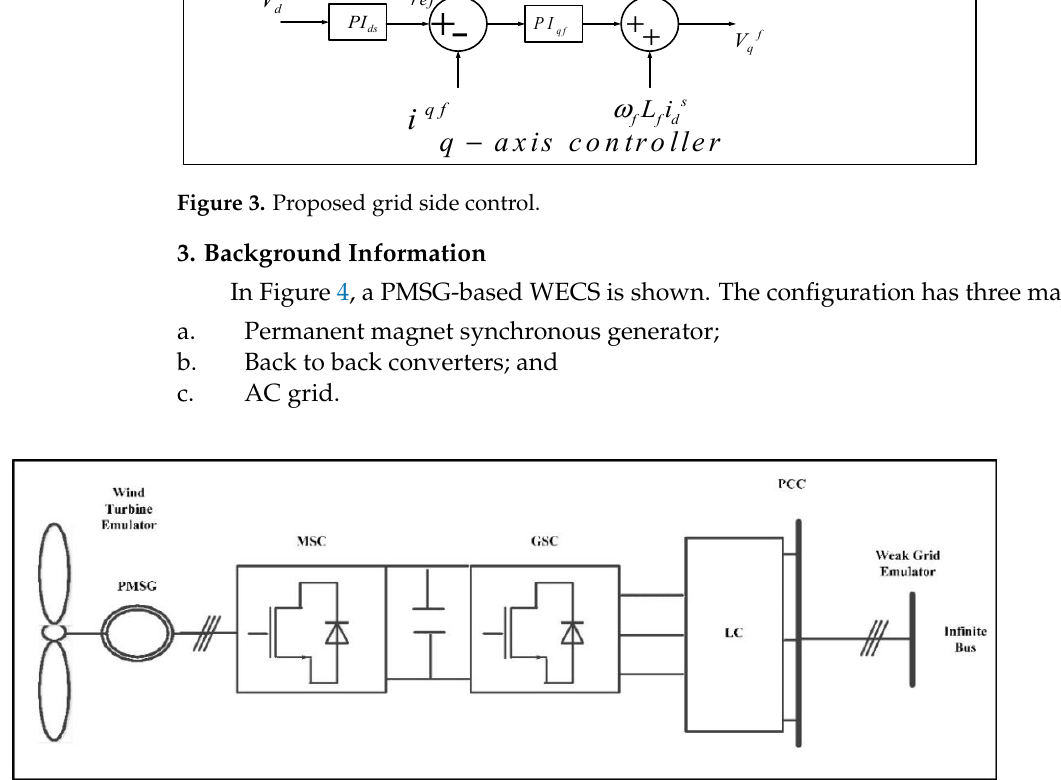
Figure 4. Proposed PMSG-based WECS configuration.